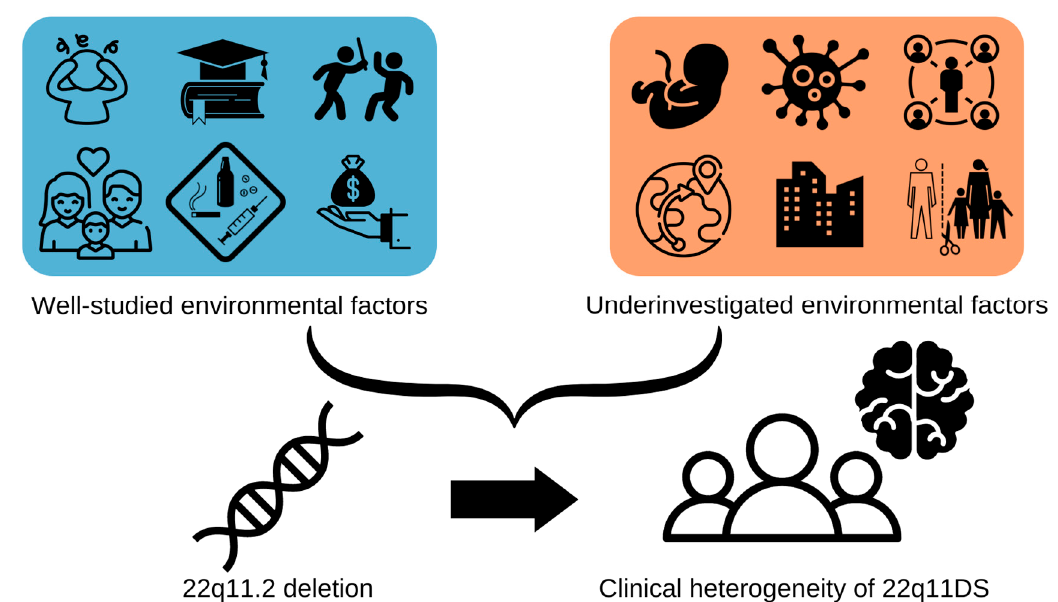
Figure 1. Visualisation of types of environmental factors, with on the left side those studied in relation to 22q11DS clinical heterogeneity (stress, parents’ education, peer violence, parents’ psychopathology, substance use, socio-economic status) and on the right side those that remain under investigated (birth complications, infection, social interactions, migration, urbanicity, family structure).